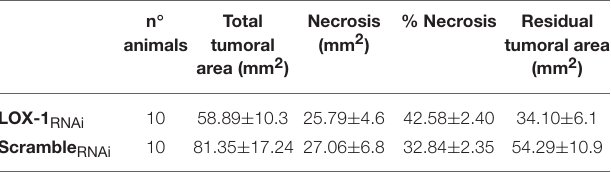
TABLE 1 | Morphometric analysis of tumor area in LOX-1 RNAi and scramble RNAi mice evaluated on H.E. sections of the xenograft